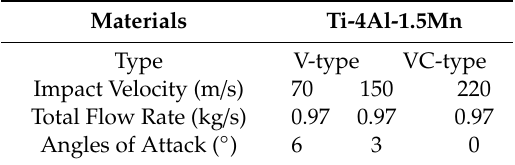
Figure 5. Bionic coating of VC-type.